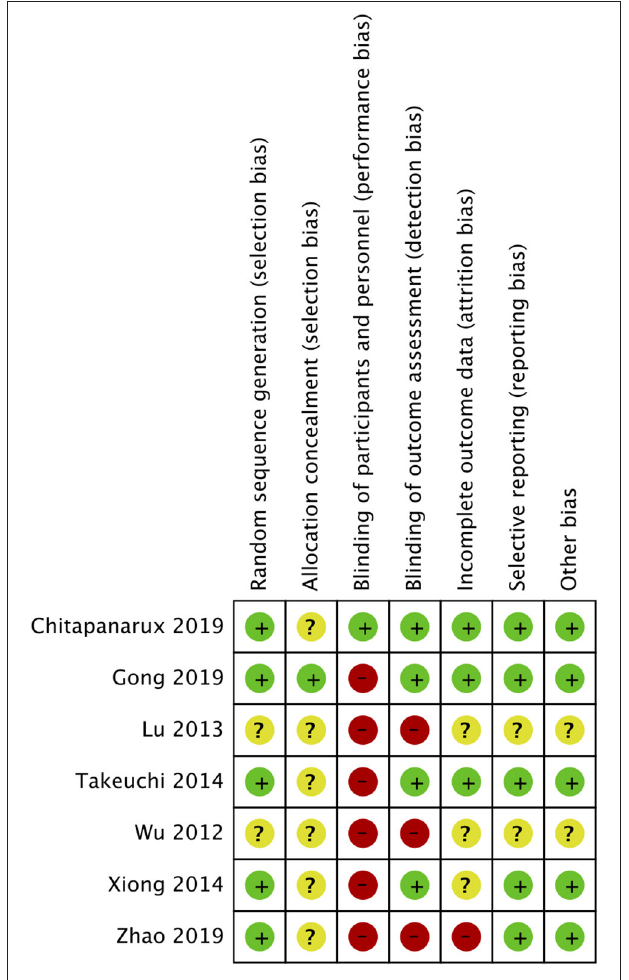
FIGURE 5 | Risk of bias